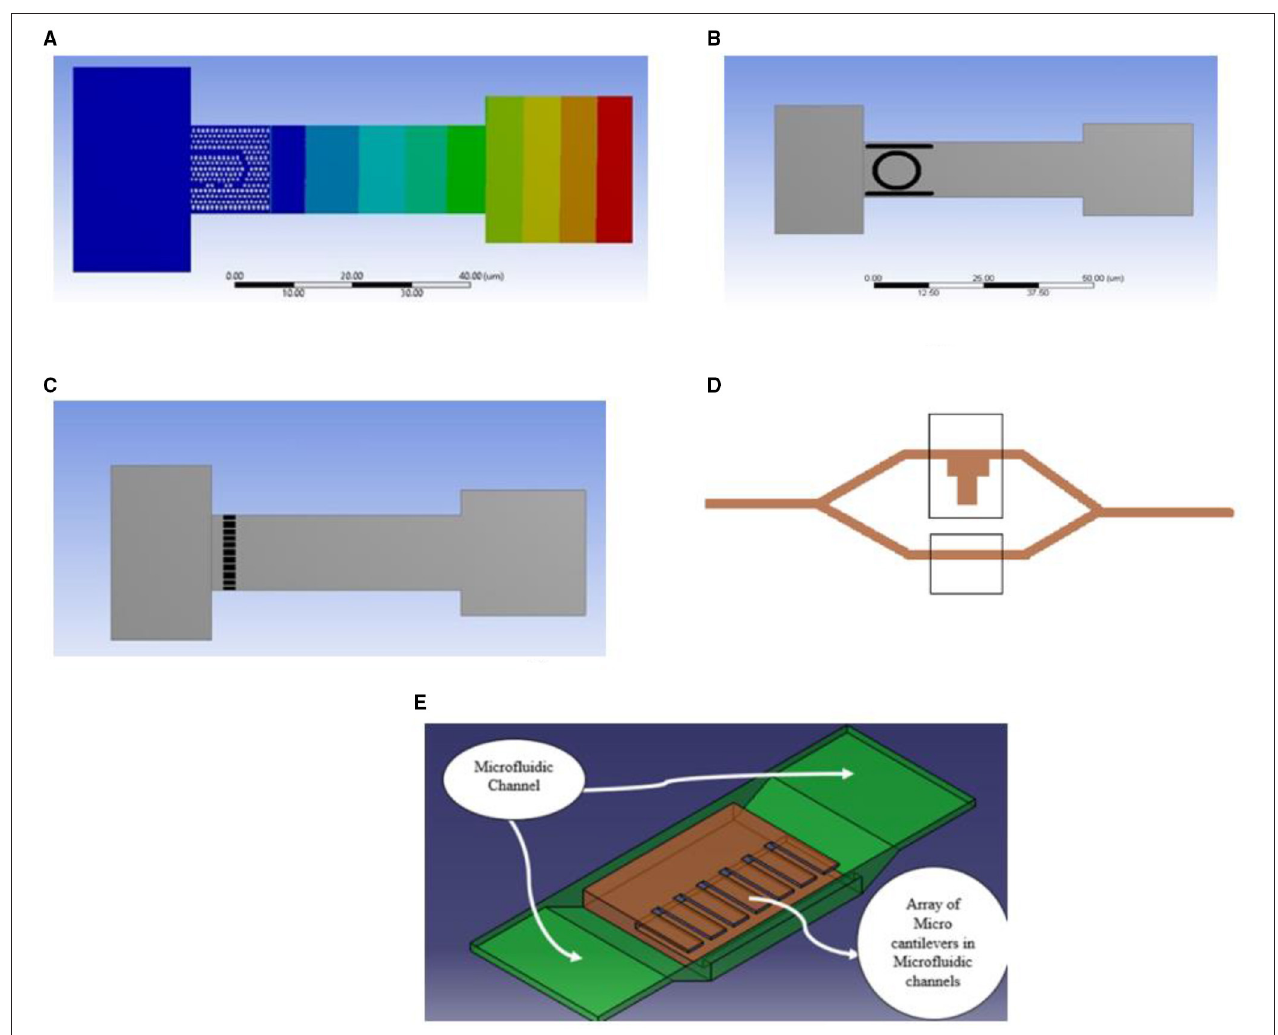
FIGURE 5 | Presents the various Microcantilever: Photonic crystal integrated Microcantilever (A) , ring resonator integrated Microcantilever (B) , FBG integrated Microcantilever (C) , MZI Integrated with Microcantilever (D) , array of Microcantilever with the microfluidic channel (E)